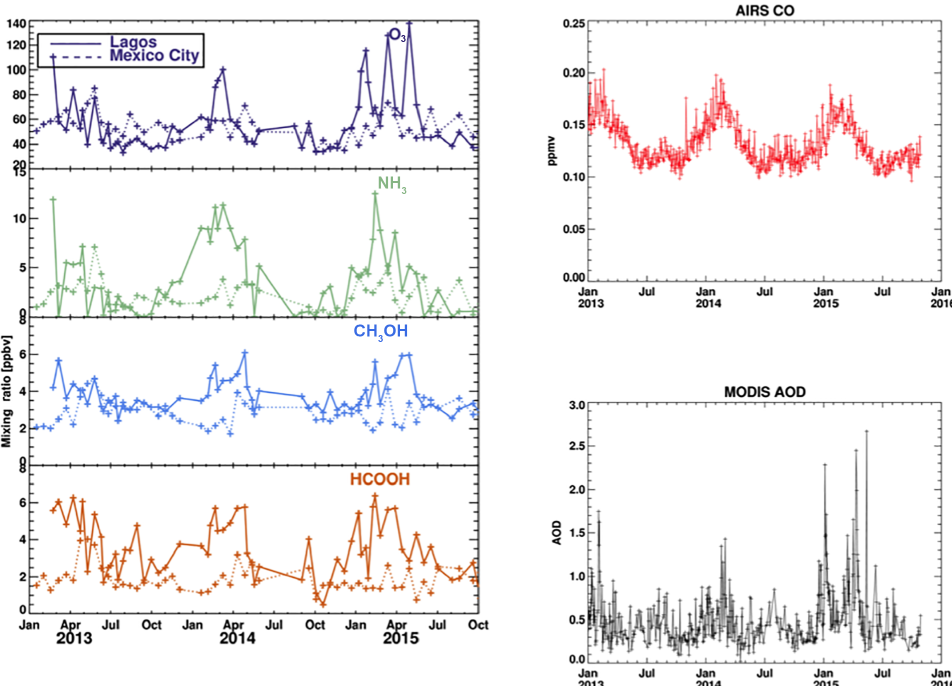
Figure 11. Means of the lower levels of each transect over the Lagos transects area (solid) and MCMA (dashed); (right panels) AIRS CO at 1000hPa (top panel) and MODIS Deep Blue AOD (bottom panel) 1 ◦ × 1 ◦ data averaged over the grid boxes crossed by the Lagos transect.